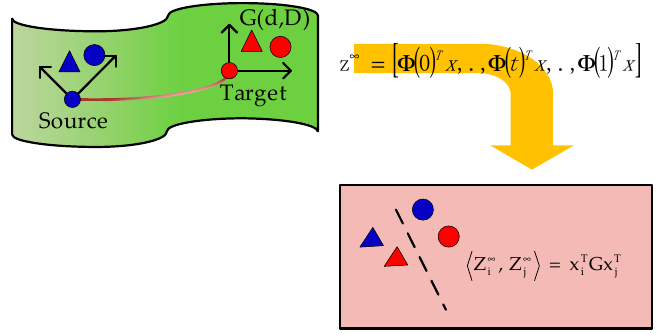
Figure 3. Geodesic Flow Kernel.